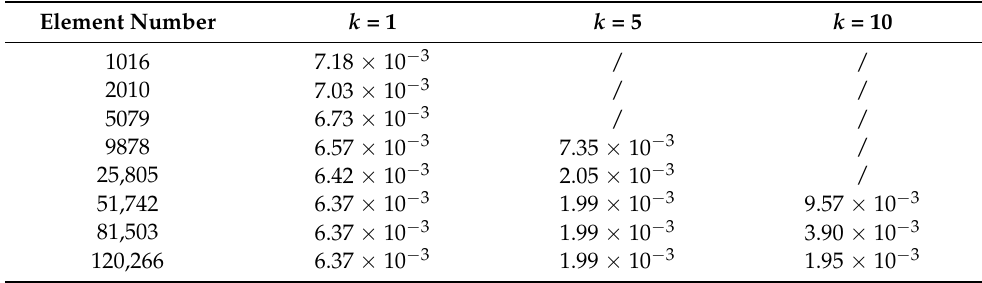
Table 2. Numerical errors (L 2 ) in reliable region obtained by the FEM + ABC (COMSOL) with respect to the increasing element number and